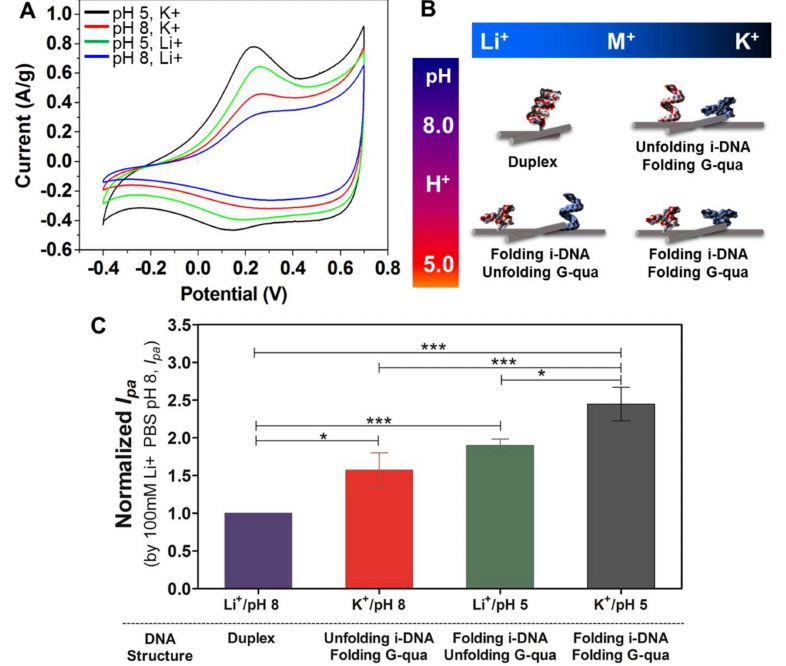
Figure 5. ( A ) Cyclic voltammograms for acidic (pH 5) and basic (pH 8) conditions in the presence of 100 mM either K + or Li + and ( B ) schematic representation of structural transformation of i-DNA/G-quadruplex between folded and unfolded states upon ionic or pH-based stimuli; ( C ) Bar graphs with error bars ( n = 5) representing the normalized anodic peak current (Ipa) of f-SWNT hybrids either with i-DNA or G-quadruplex at pH 5 (Green/Li + and Grey/K + ) and pH 8 (purple/Li + and red/K + ). Annotations *, **, and *** correspond to differences with p values less than 0.05, 0.005, and 0.0005,